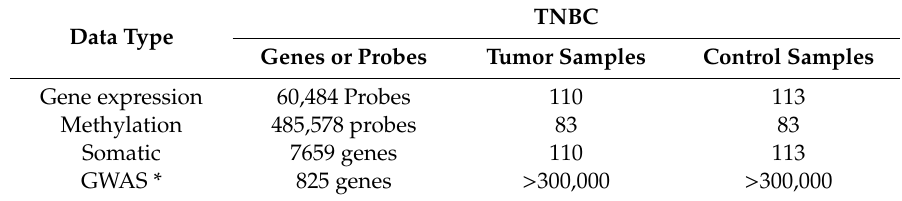
Figure 1. Project design and integrated genomic analysis workflow integrating information on germline, somatic and epigenomic variations using gene expression data as the intermediate phenotype. Table 1. Characteristics and distribution of the original data sets used in the study.